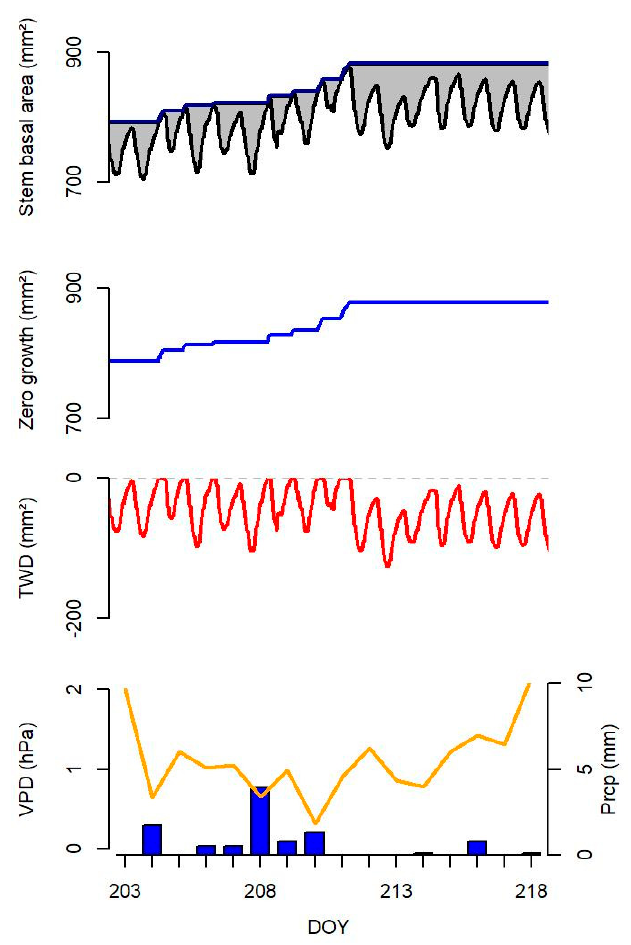
Figure 1. Exemplary illustration of the course of the stem basal area variation and the two applied indices, zero growth (ZG) and tree water deficit (TWD), for a period of 16 days in the growing season 2015 of an example spruce tree. The climatic graph of vapor pressure deficit (VPD) and daily precipitation sum (Prcp) illustrated how the deficit of water led to a stagnation of the zero growth and a decrease in the tree water deficit during the last five days of the example period.